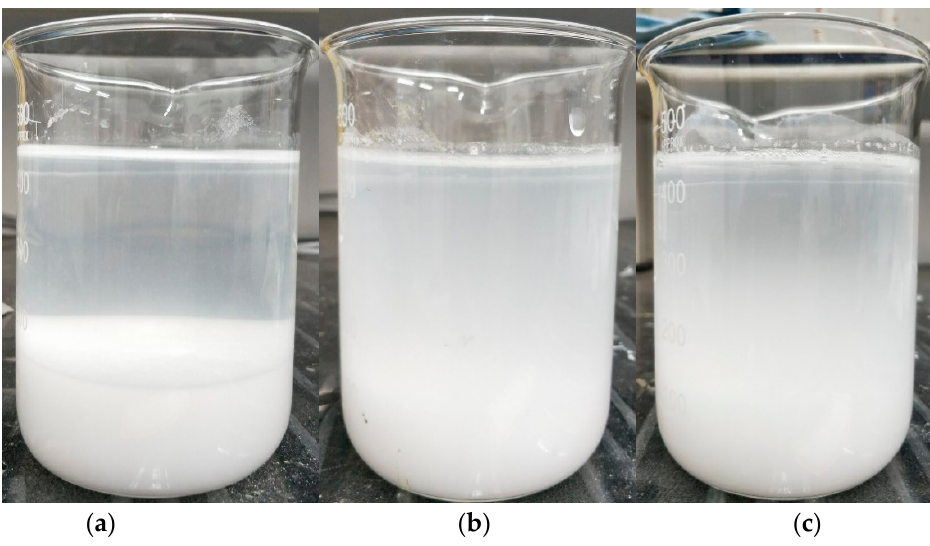
Figure 3. Stability of NS and MNS in saturated calcium hydroxide. ( a ) NS; ( b ) MNS2; ( c ) MNS3.